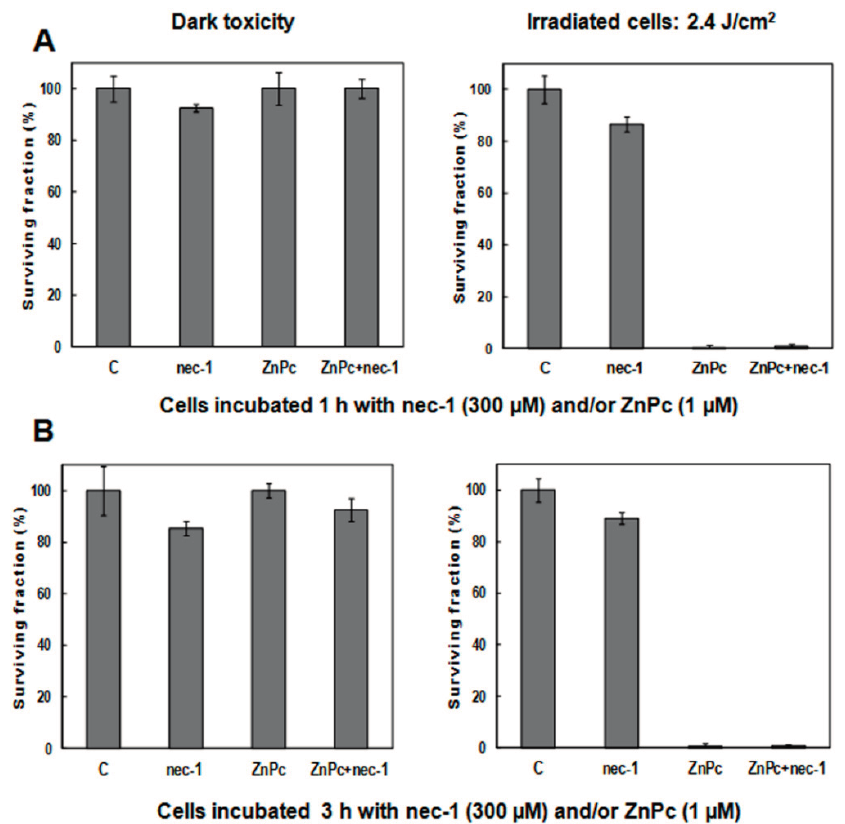
Figure 4. Survival of HeLa cells incubated with 1 µM ZnPc, 300 µM nec-1 or ZnPc − nec-1 and evaluated by the MTT assay 24 h after treatments. ( A ) Cells treated 1 h with ZnPc; ( B ) cells treated 3 h with ZnPc. Results represent the average of six independent